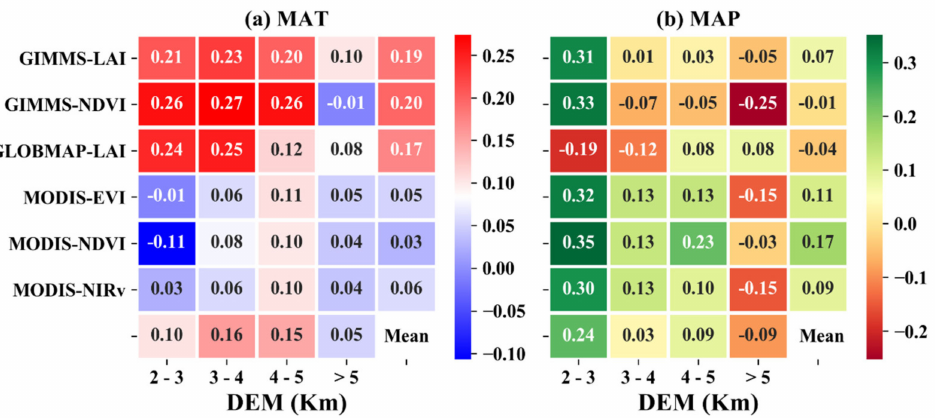
Figure 10. Correlation between vegetation indices (VIs) and climatic factors (( a ) MAT (Mean Annual Temperature) and ( b ) MAP (Mean Annual Precipitation)) at the elevations of 2–3, 3–4, 4–5, and >5 km from 2001 to